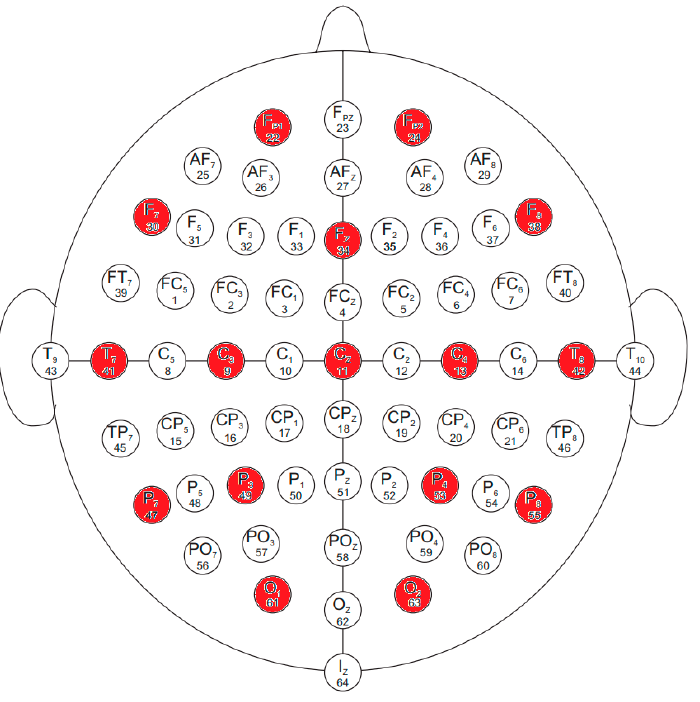
Figure 1. EEG electrodes used in the PhysioNet database [26].